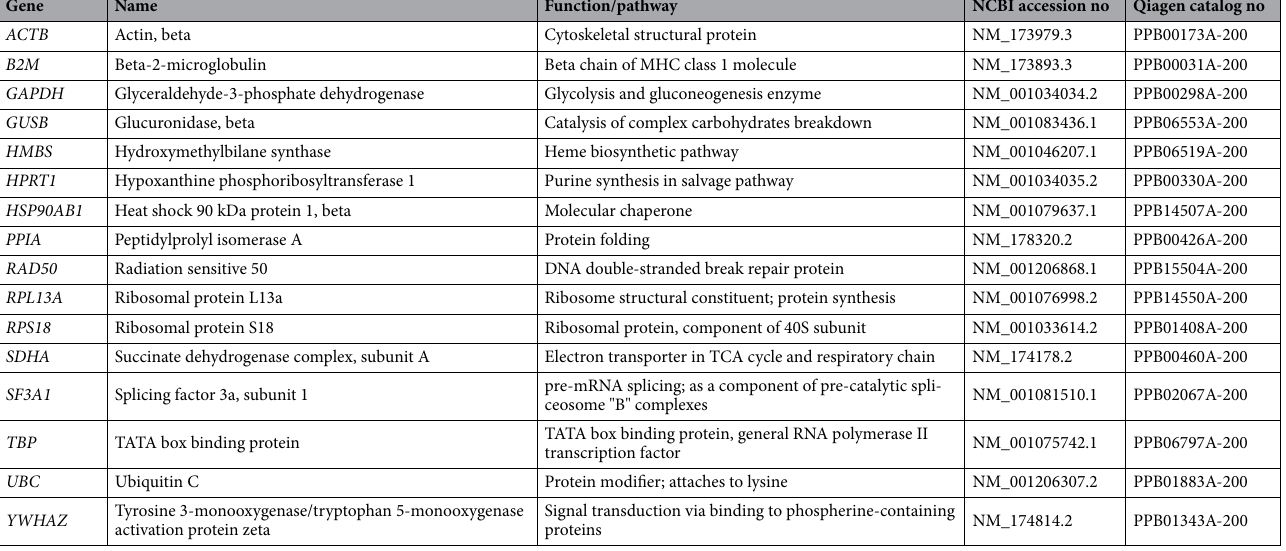
Table 1. Overview and details of candidate RGs evaluated in this